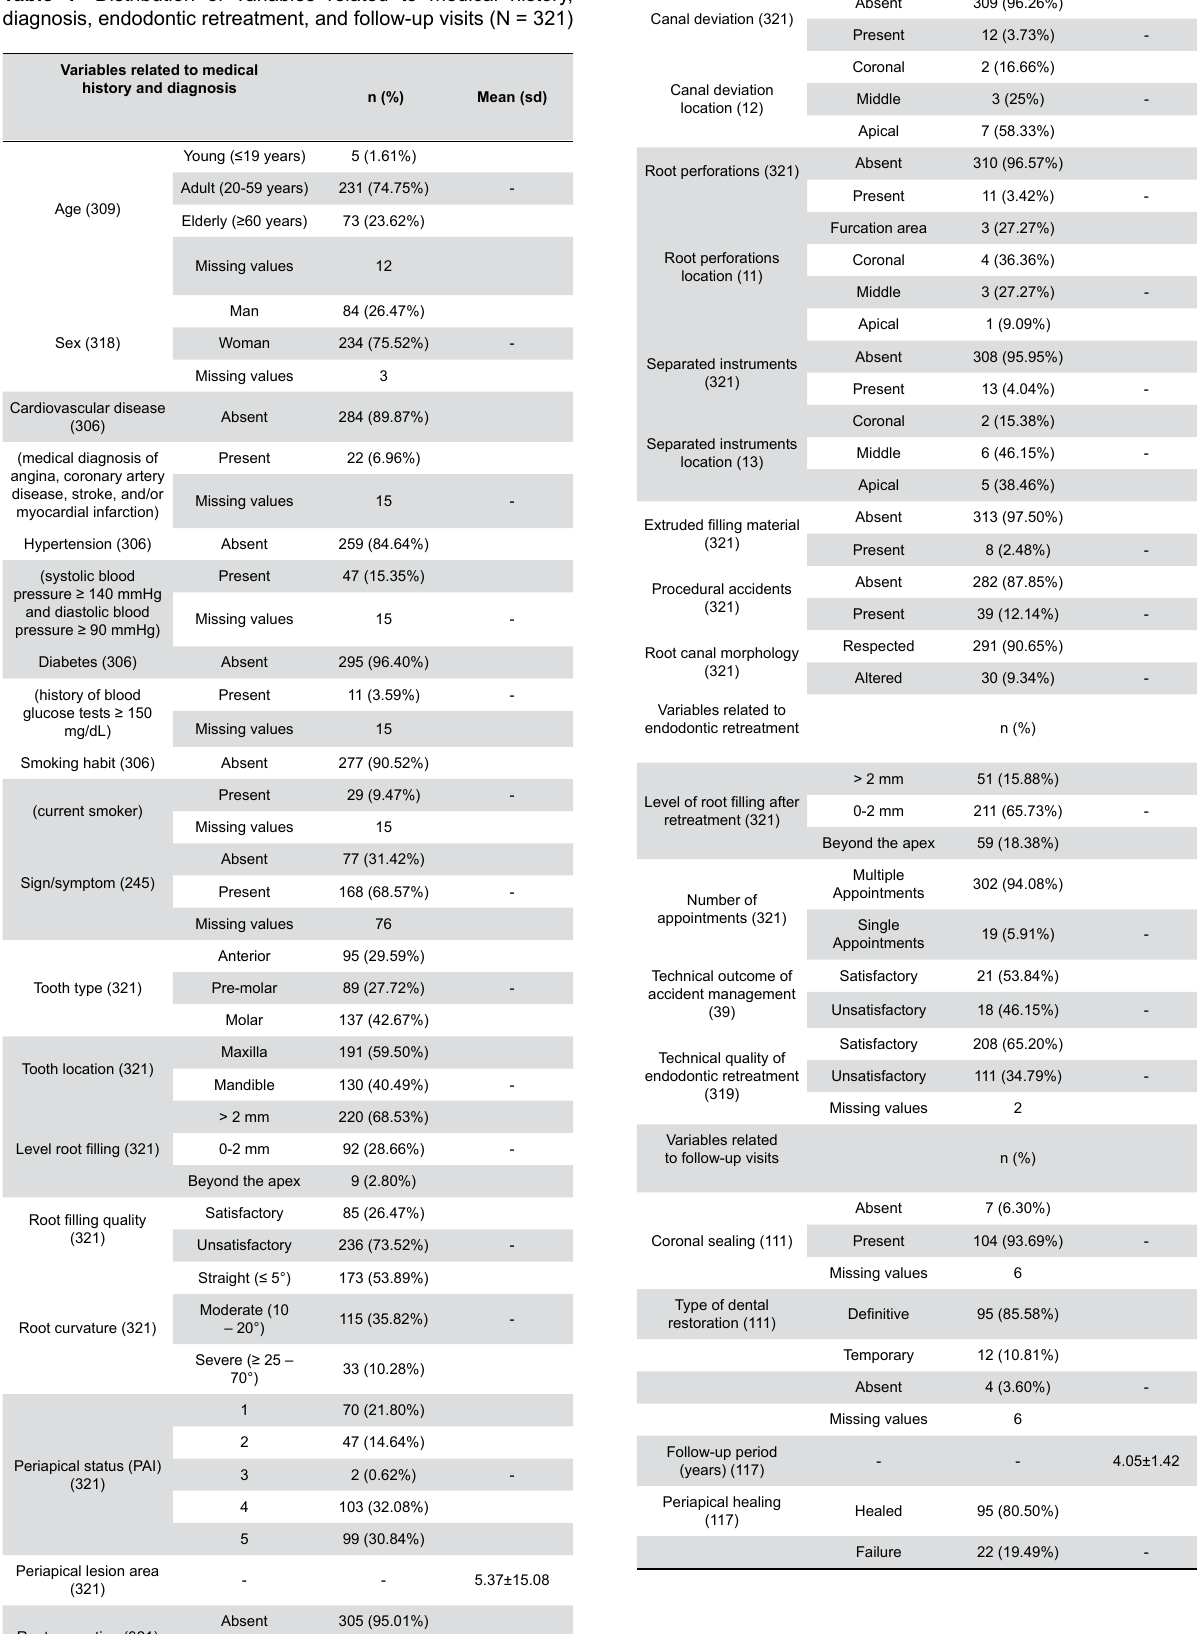
Root canal retreatment: a retrospective investigation using regression and data mining methods for the prediction of technical quality and periapical